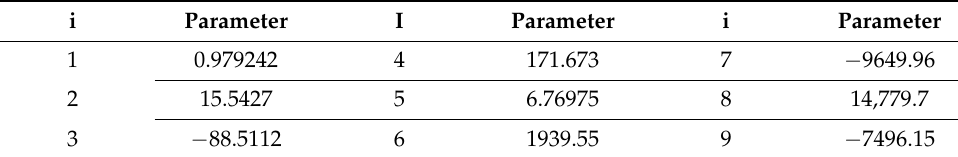
Table 3. Parameters for Equation (10).